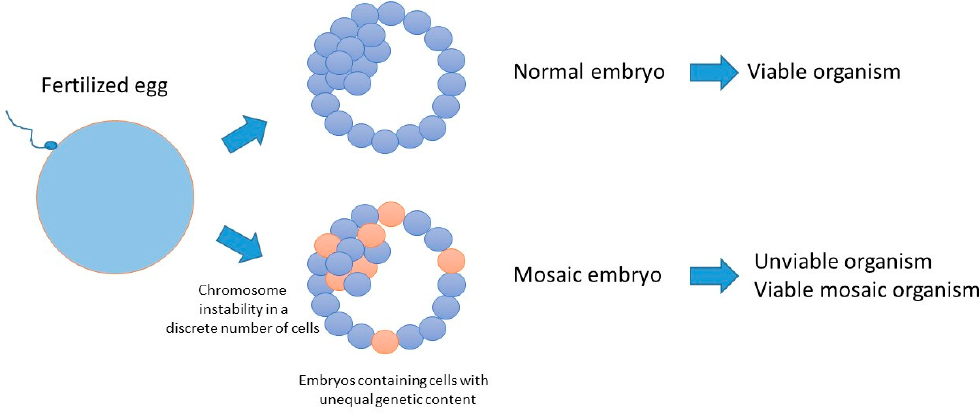
Figure 4. Consequences of chromosome abnormalities in early mammalian embryos. Each circle represent a blastomere, normal (blue) or having a different genetic content (orange).